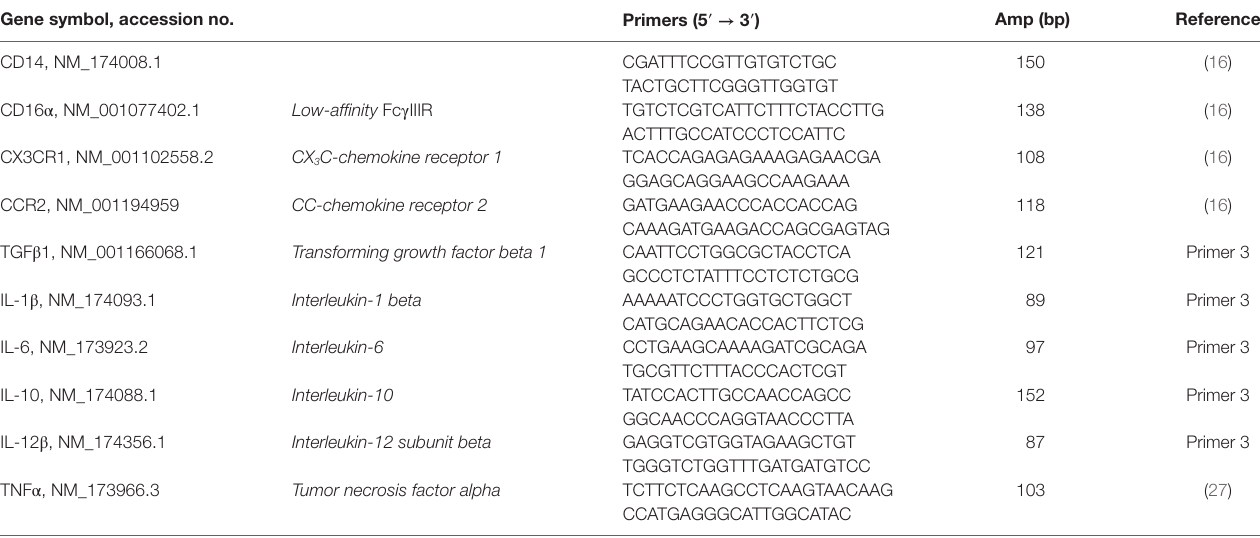
TaBle 1 | list of primers used for reverse transcription-quantitative Pcr (rT-qPcr). gene symbol, accession